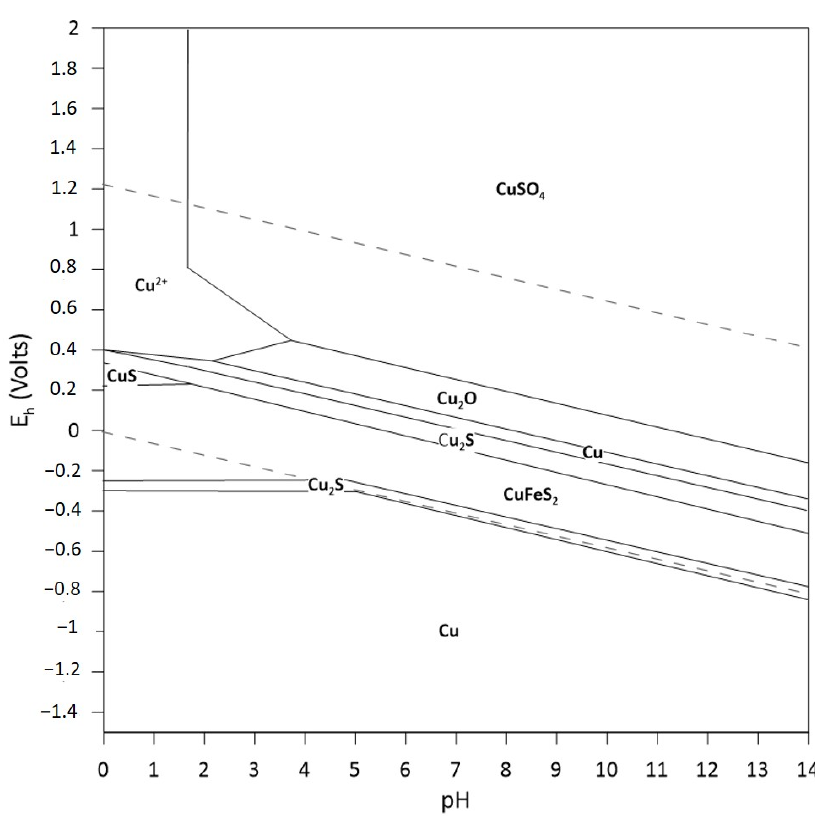
Figure 4. Pourbaix diagram, system Fe-Cu-S-H 2 O at 25 °C, 1 mol L-1 Cu, Fe and S (HSC Chemistry 9.0, Metso Outotec, Helsinki, Finland).